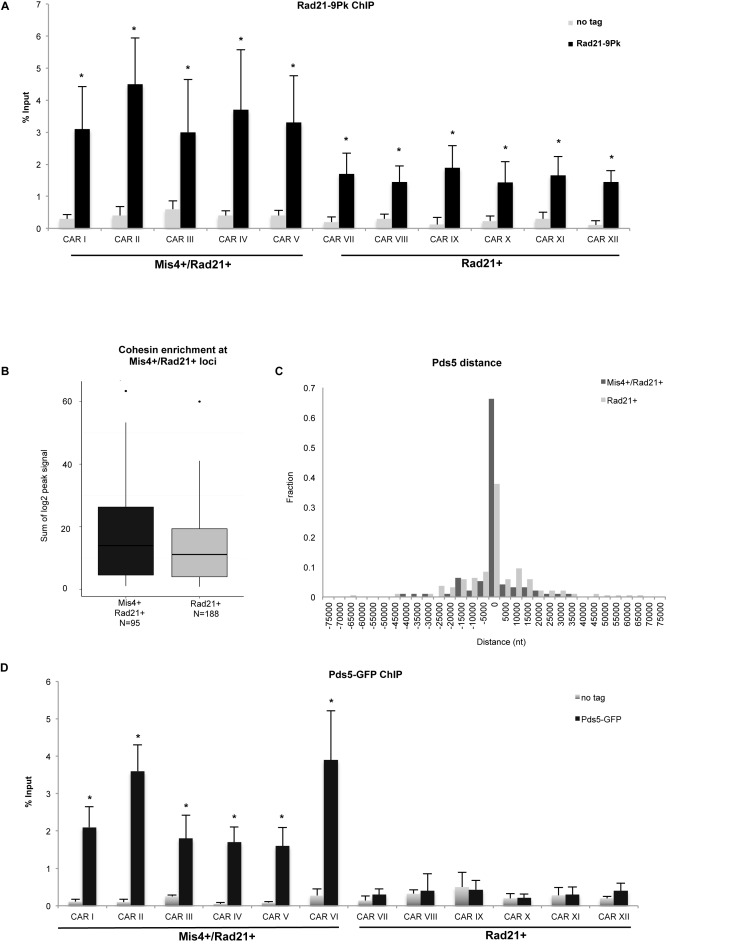
Cohesin and Pds5 co-localize at Mis4+/Rad21+ loci. (A) ChIP-qPCR analysis showing Rad21-Pk9 at selected CARs. No tag strain was used to assess the background levels. * P < 0.05, two-tailed, paired student's t-test for Rad21-Pk9 compared to background levels. Error bars represent SD, n = 3. (B) Cohesin enrichment at Mis4+/Rad21+ versus Rad21+ sites. Boxplots comparing sum of log2 Rad21 ChIP signal at Mis4+/Rad21+ versus Rad21+. P < 0.05, one-sided Wilcoxon Rank Sum test. (C) Pds5 enrichment at Mis4+/Rad21+ versus Rad21+ sites. Bar graph shows distances between Pds5 peak margins at Mis4+/Rad21+ and Rad21+ sites in 5000 nt bins. An overlap between intervals spanned by a Mis4+/Rad21+ and Pds5 peak gives a distance of 0. (D) ChIP-qPCR analysis showing Pds5-GFP at selected CARs. No tag strain was used to assess the background levels. *P < 0.05, two-tailed, paired Student's t-test for Pds5-GFP compared to background levels. Error bars represent SD, n = 3.